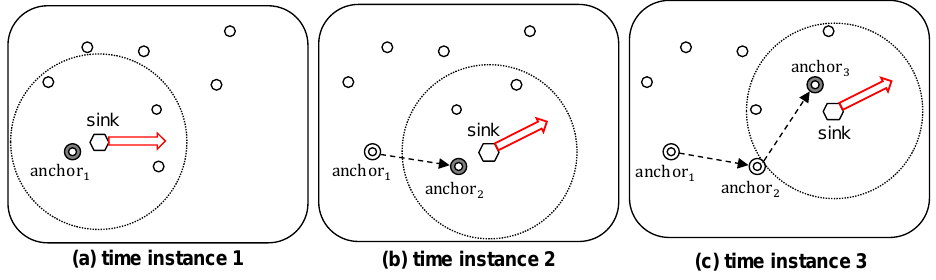
Figure 7. Anchor Node Change According to the Location of the Sink Node.